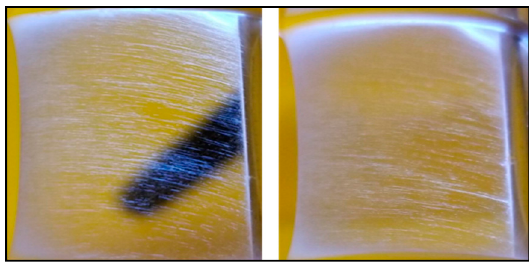
Figure 5. Aligned fibers formed in the mesh of the improved system (shadow is alligator clip).